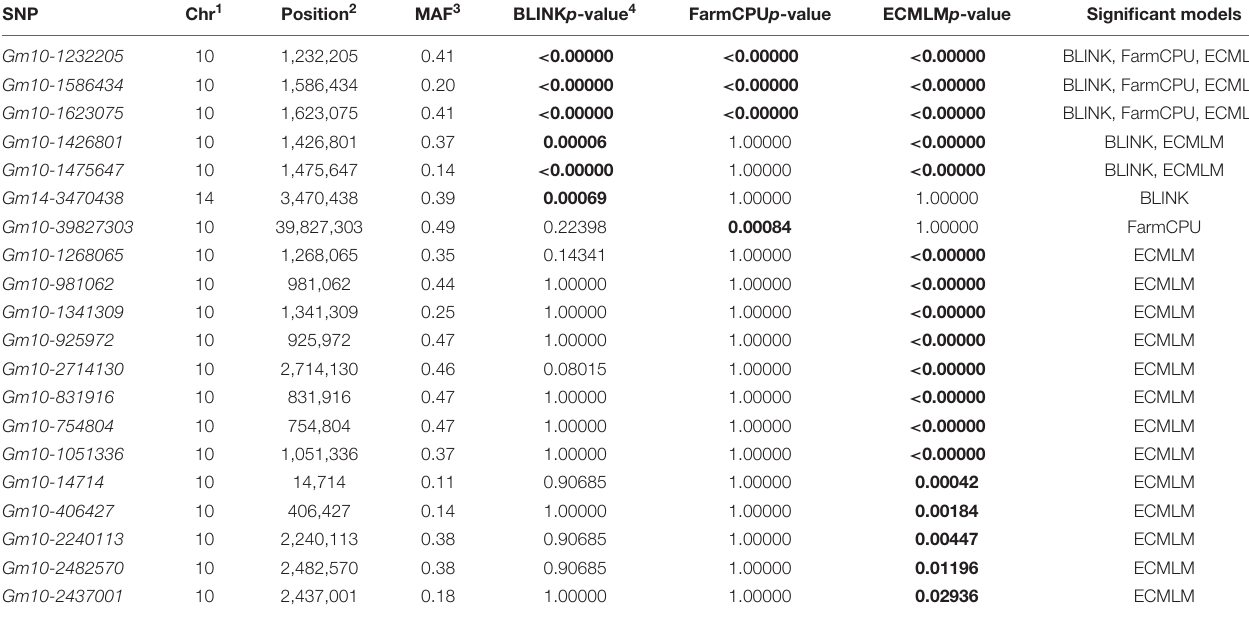
TABLE 3 | Summary of significant SNP-trait associations identified by GWAS using the BLINK, FarmCPU, and ECMLM